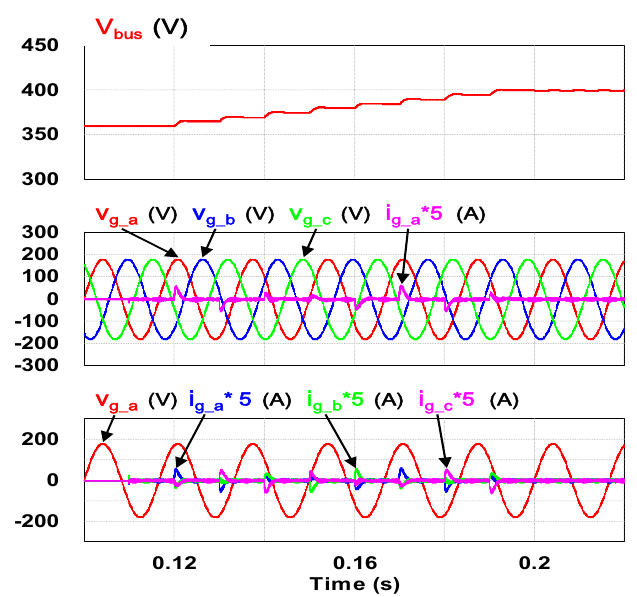
Figure 16. Waveforms of DC bus voltage ( top ), grid three-phase voltages and a-phase current ( mid ), grid a-phase voltage and three-phase currents ( bottom ).